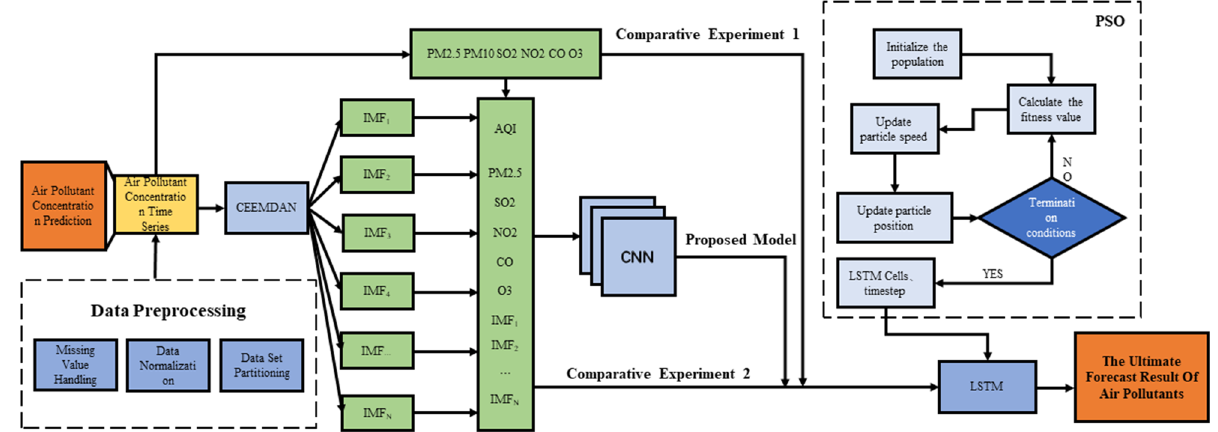
Figure 3. Flow chart of air pollution prediction based on the integrated CEEMDAN-CNN-LSTM